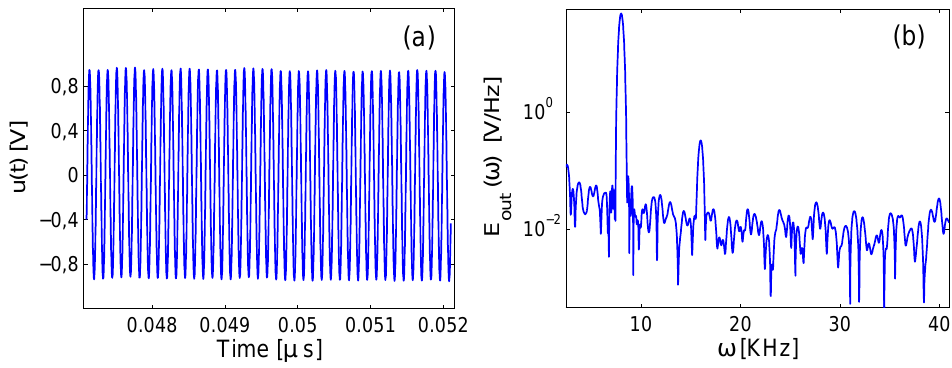
Figure 4. ( a ) Typical signal recorded with a sinusoidal source function and ( b ) relative